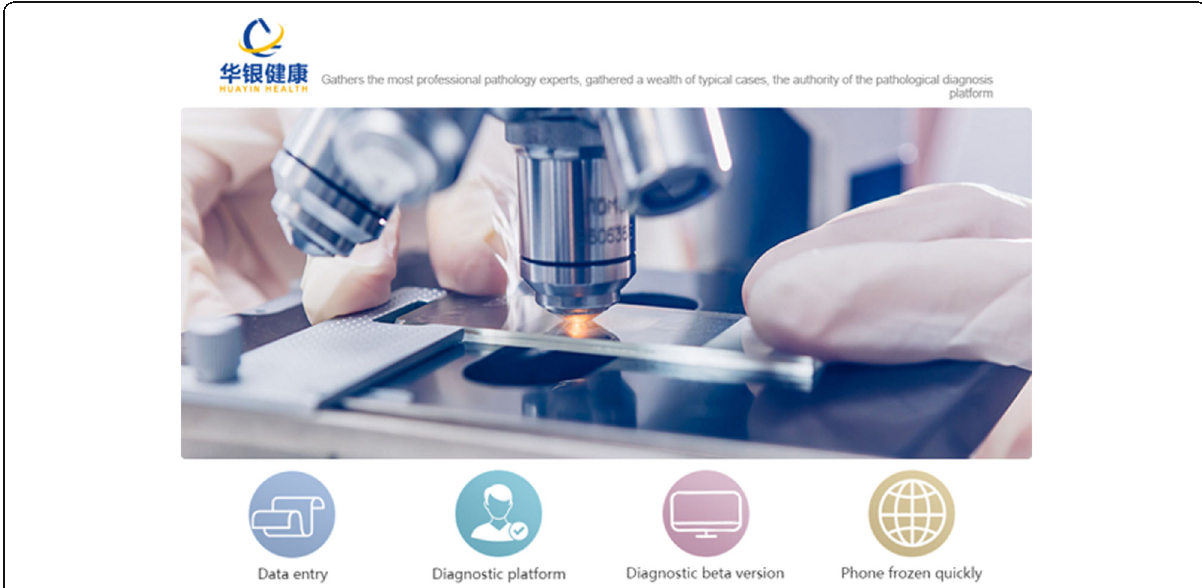
Fig. 1 Customized SMU-HUAYIN TP consultation platform web portal. We have obtained permission from the copyright holders to reproduce the